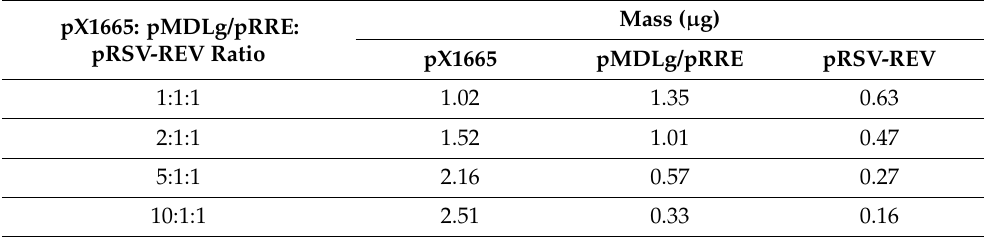
Figure 2. Schematic outline of the production of HER2-specific HIV-1-based VLPs. ( A ) Transfection of HEK-293T cells plated at 7.0 × 10 6 cells/plate in 10 cm plates with pX1665 and pMDLg/pRRE at a 1:1 ratio and VLP collection at 24 h post-transfection and 52 h post-transfection. ( B ) Transfection of HEK-293T cells plated at 1.0 × 10 6 cells/well into 6-well plates with pX1665, pMDLg/pRRE and pRSV-REV at different ratios and VLP collection at 48 h post-transfection. Table 1. Different plasmid ratios used for transfection of HEK-293T cells in 6-well plates .